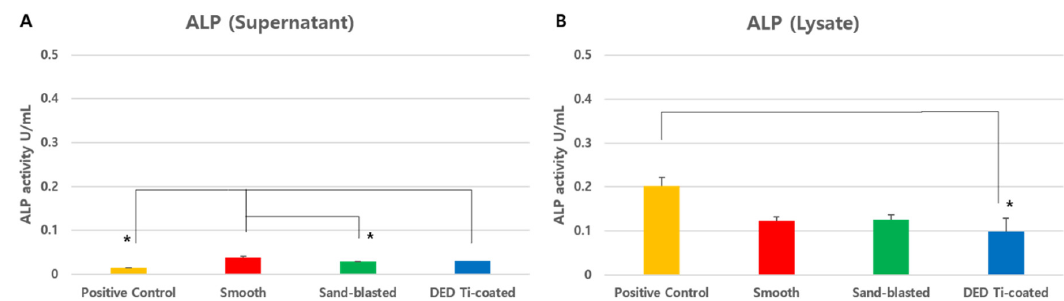
Figure 6. The result of alkaline phosphatase (ALP) activity assay from supernatant (A) and lysate (B). A: In the supernatant, there were significant differences among the four experimental groups ( p = 0.0003). In the comparison between groups, the positive control group exhibited significantly lower ALP activity than the smooth and DED groups. B: In the lysate, ALP activity was lower in the DED group than in that in the positive control. (* p < 0.05). (ALP: alkaline phosphatase, DED: direct energy deposition).